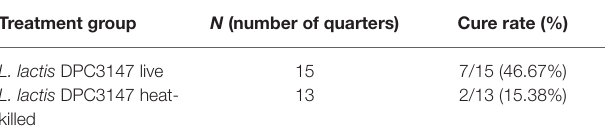
TABLE 2 | Overall cure rates for each of the treatment groups investigated in this trial.